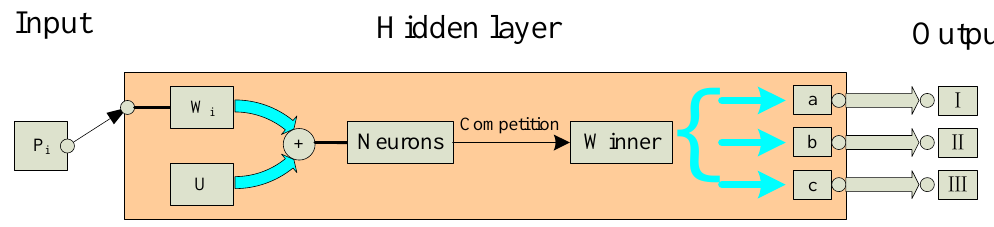
Figure 11. Schematic diagram of the self-organizing model (SOM) applied to batteries sorting.